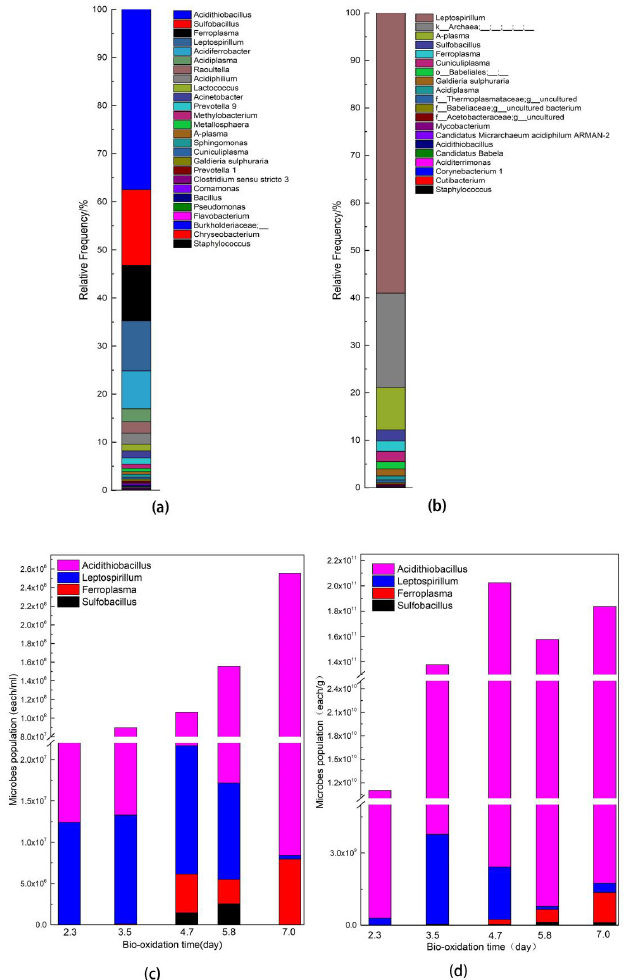
Figure 7. Microbe culture, frequency and population. ( a ) relative frequency of microbes from Zijinshan Gold and Copper mine waste acid residue, ( b ) relative frequency of microbes from Zijinshan Gold and Copper mine AMD, ( c ) microbe populations in solution during continuous bio-oxidation process, ( d ) microbe populations in solids during continuous bio-oxidation process.